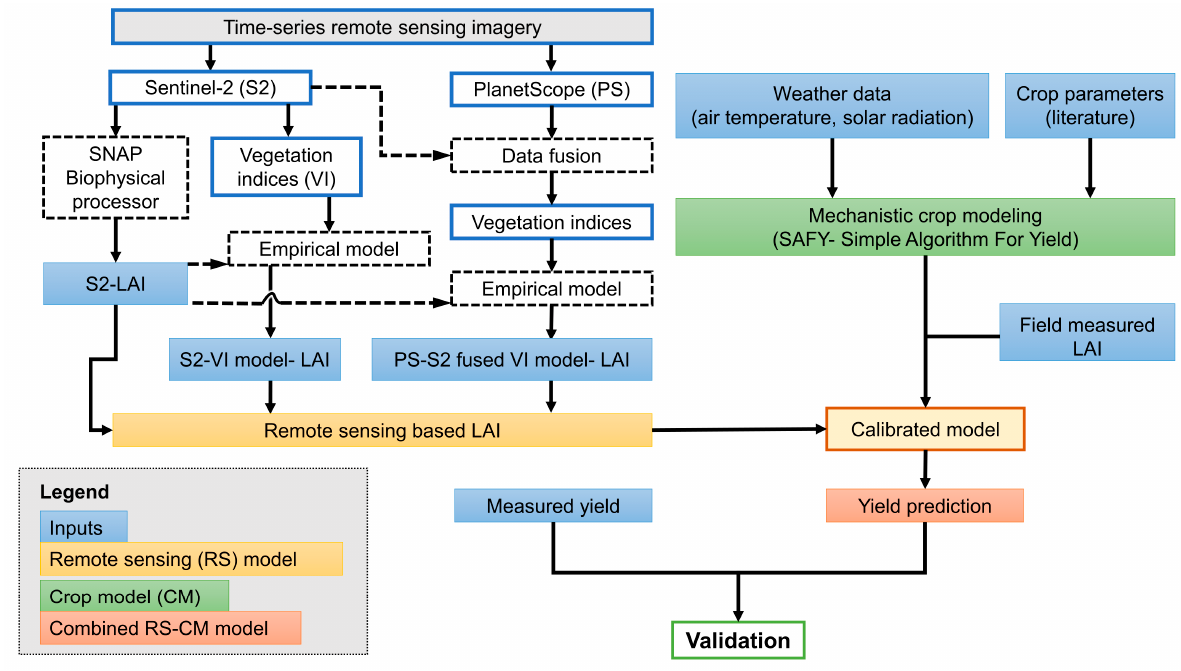
Figure 3. The processing chain for yield modeling through the assimilation of high-resolution satellite images into the SAFY model.